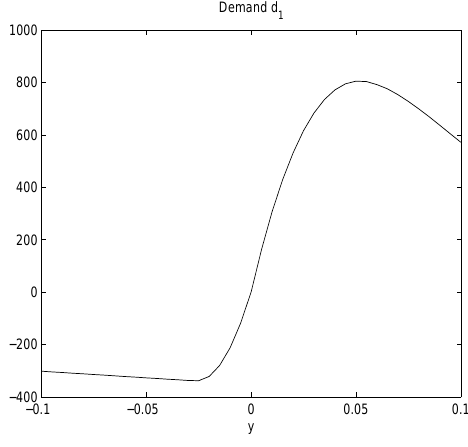
Figure 21. Excessive demand d 1 ( y ) as a function of